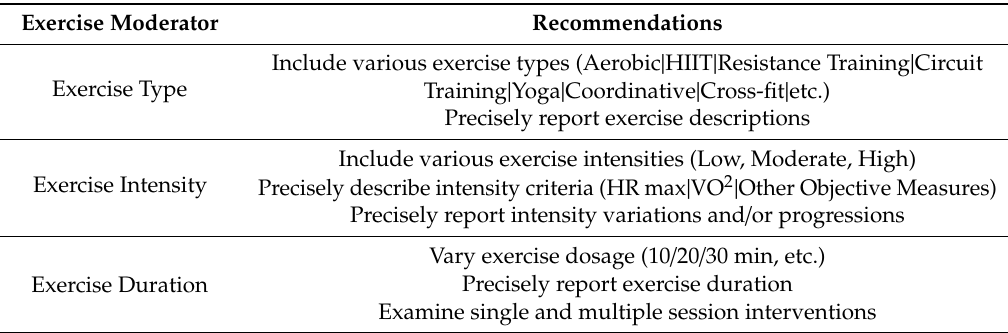
Table 4. Future research recommendations to optimize exercise intervention